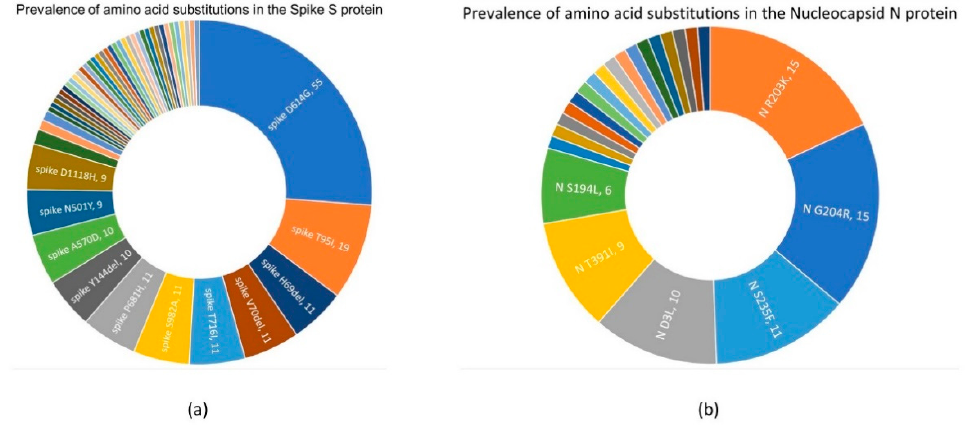
Figure 4. Various amino acid substitutions detected in: ( a ) the spike and ( b ) the nucleocapsid proteins. The number of strains in which each substitution was detected is shown next to said substitution on the wheel.